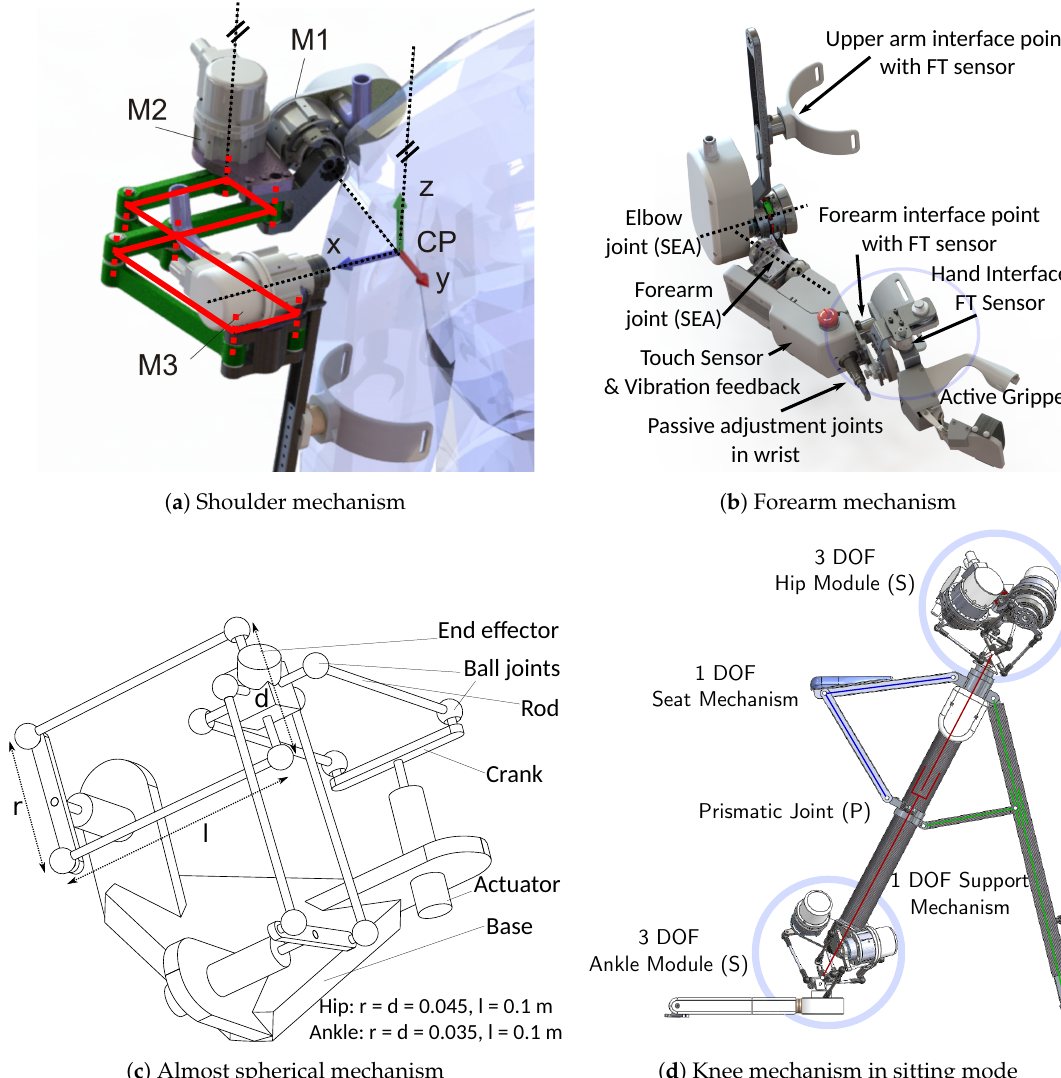
Figure 3. Various mechanisms in R ECUPERA full-body exoskeleton. Hip and Ankle Joints Hip and ankle joints are designed as 3 DOF orientational joints in the